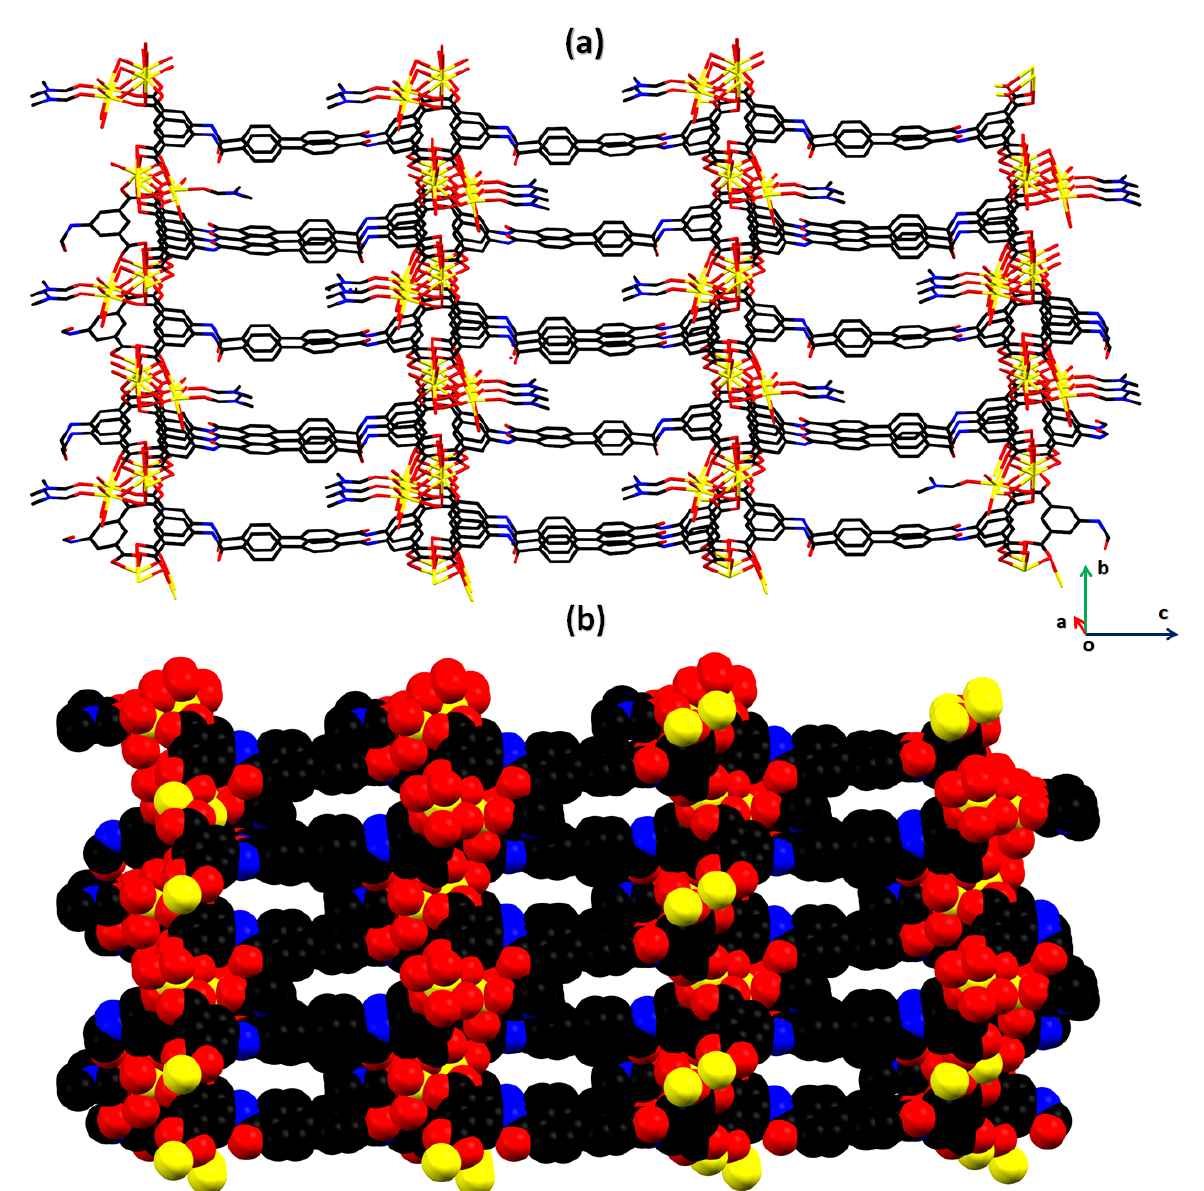
Figure 5. ( a ) X-rays crystal structure of CdMOF showing channels along the a-axis. ( b ) CPK model showing the dimensions of the channel windows (13.164 × 7.157) Å 2 along the a-axis. H-atoms and minor parts of disordered atoms are not shown for clarity.